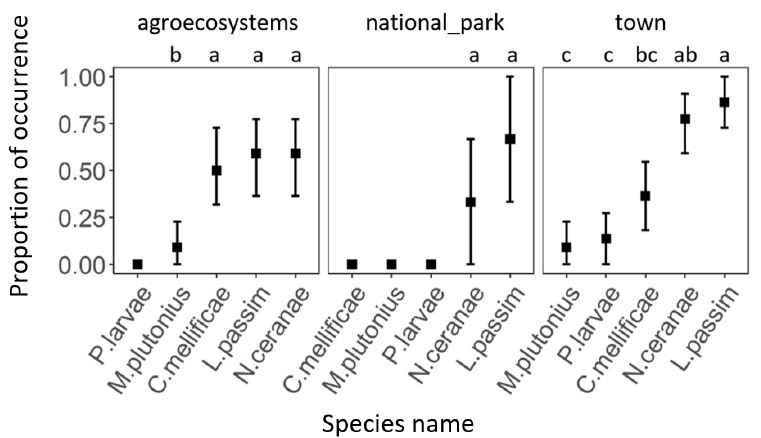
Figure 3. The comparison of proportion of eukaryotic pathogen occurrence within each habitat type. Black squares represent means and the error bars represent 95% confidence intervals. Significant differences (<0.05) are indicated by different letters.